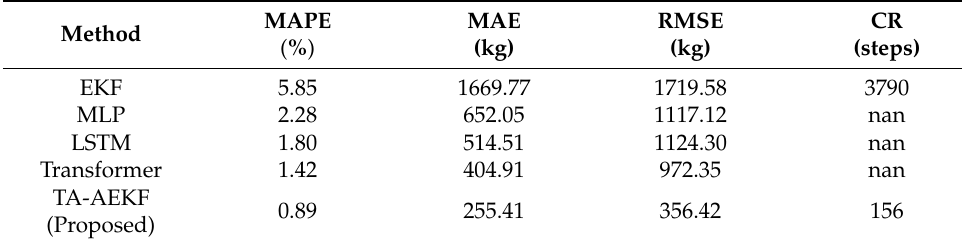
Table 2. Evaluation metrics of simulation test 1 results.